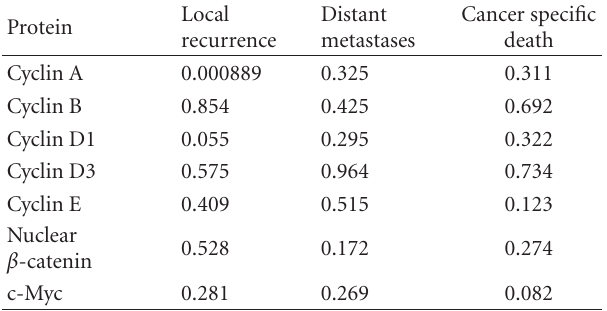
Table 9: Kaplan-Meier Log Rank Test. P -values without Bonferroni